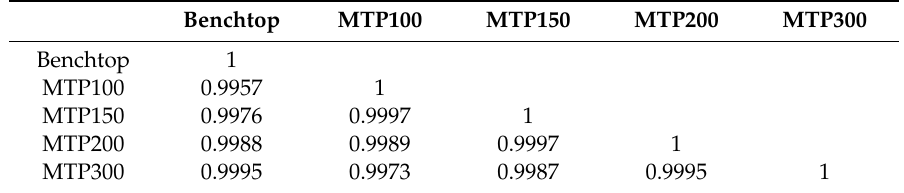
Table 1. Correlation matrix for optical density/absorbance of all extra virgin olive oils with different instruments and different volumes (weight) with a significance level of 0.05.